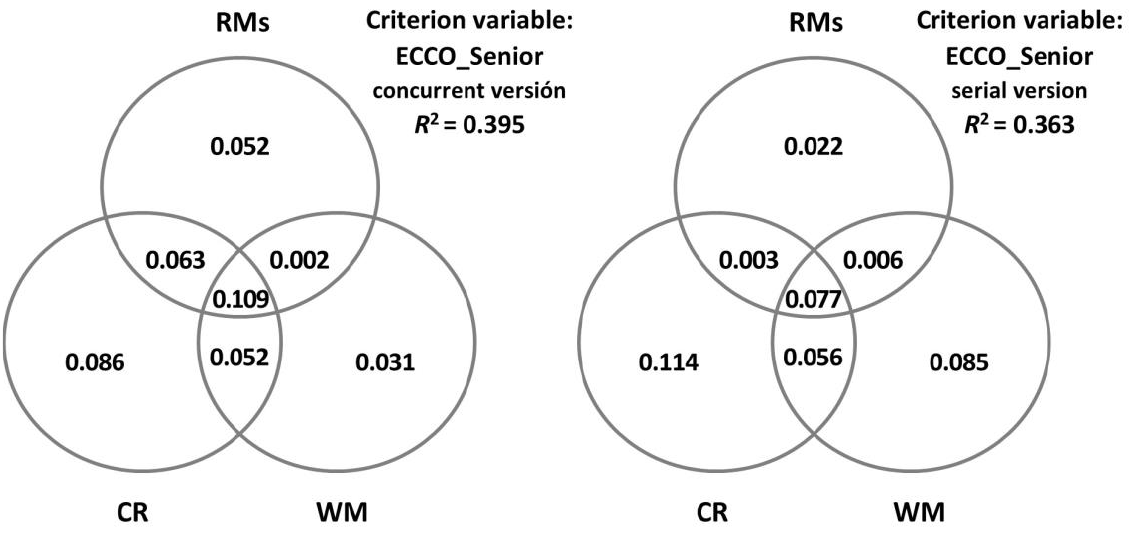
Figure 2. Decomposition of the variance in the ECCO_Senior test explained jointly and uniquely by